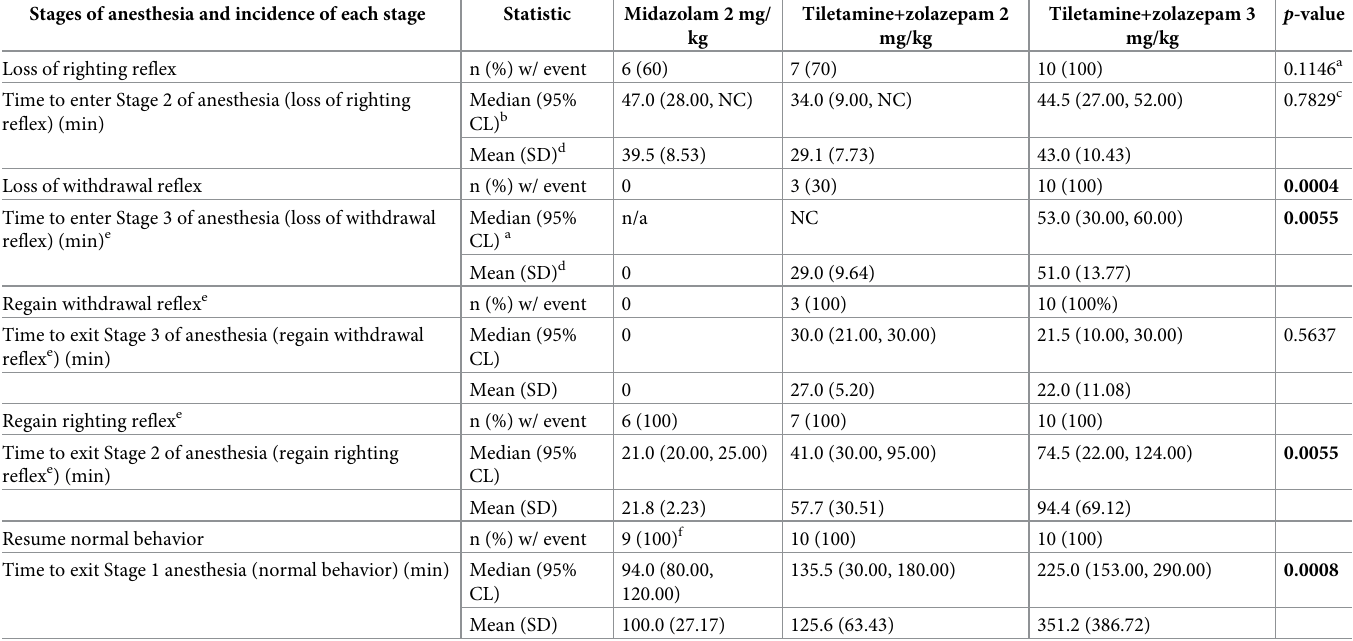
Table 2. Time course of anesthesia stages after administration of three different drug regimens in ball pythons. Stages of anesthesia and incidence of each